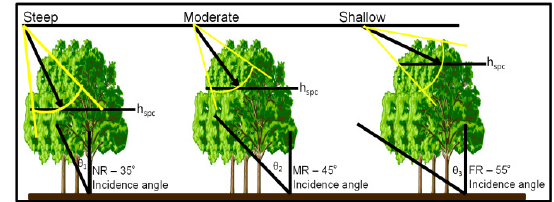
Figure 4. Incidence angle effects on h spc retrieval for a forest across one flight line strip of data from NR (steep incidence angle) to FR (shallow incidence